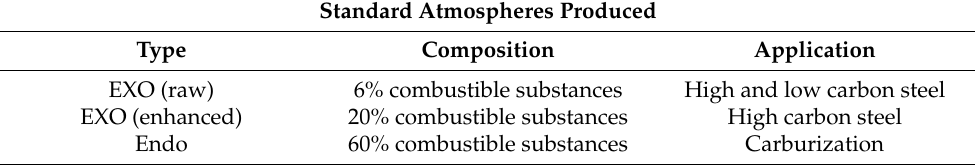
Table 1. Atmospheres commonly used during heating.